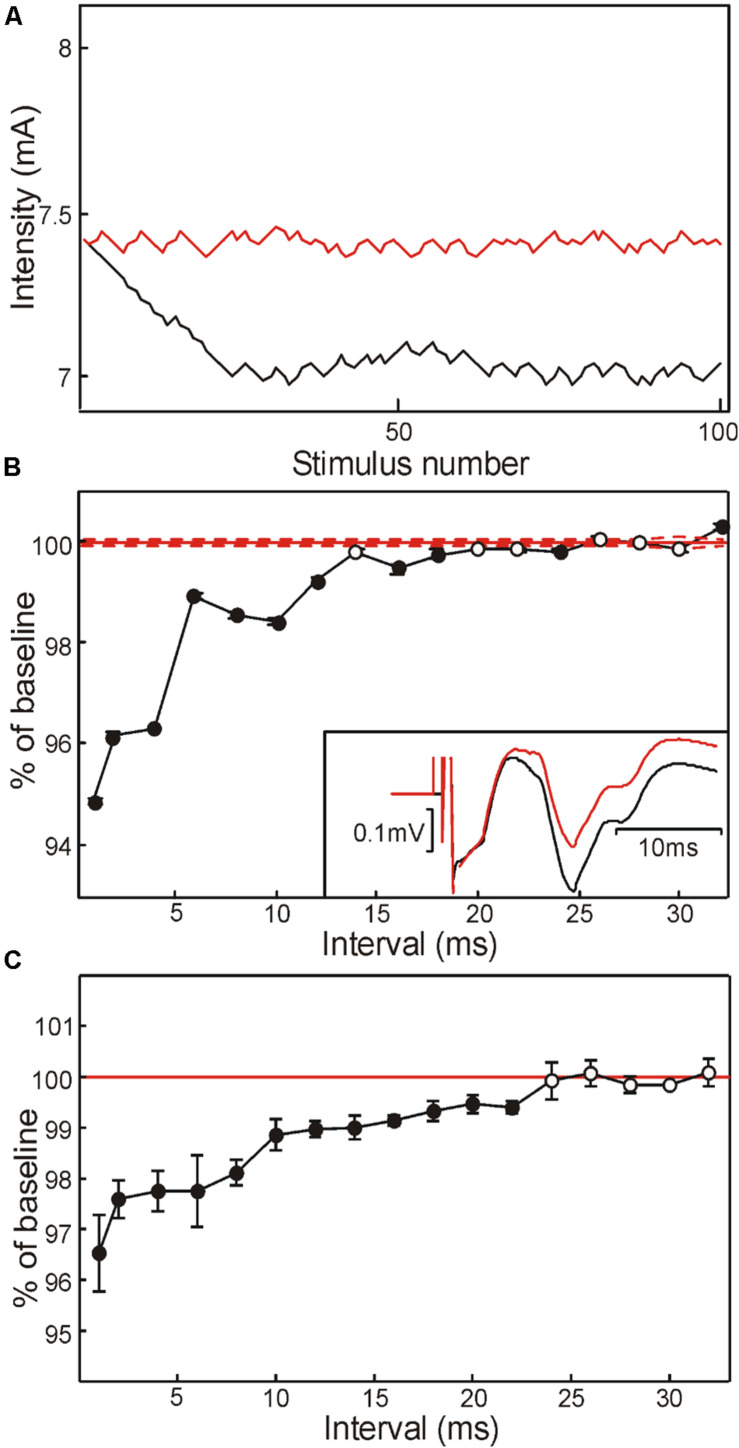
Modulation of axon threshold assessed using threshold tracking of M response in healthy human subjects. (A) Variation of stimulus intensity with successive stimuli, as the tracking algorithm attempted to match the target response size. Red trace, test stimulus alone; black trace, condition and test stimulus with interval of 1 ms. (B) Change in M wave threshold with different condition-test intervals, in a single subject. Threshold is expressed as a percentage of that measured following test stimulation alone (red). Points are the mean and SEM measured over the last 50 stimuli at a given interval, by which point the algorithm had converged [see panel (A)]. Inset illustrates averaged traces from this subject following test stimulus alone (black) and conditioned at a 1 ms interval (red). (C) Modulation in M wave threshold averaged across five healthy human subjects. In panels (B,C), filled symbols indicate points significantly different from 100% (P < 0.05).